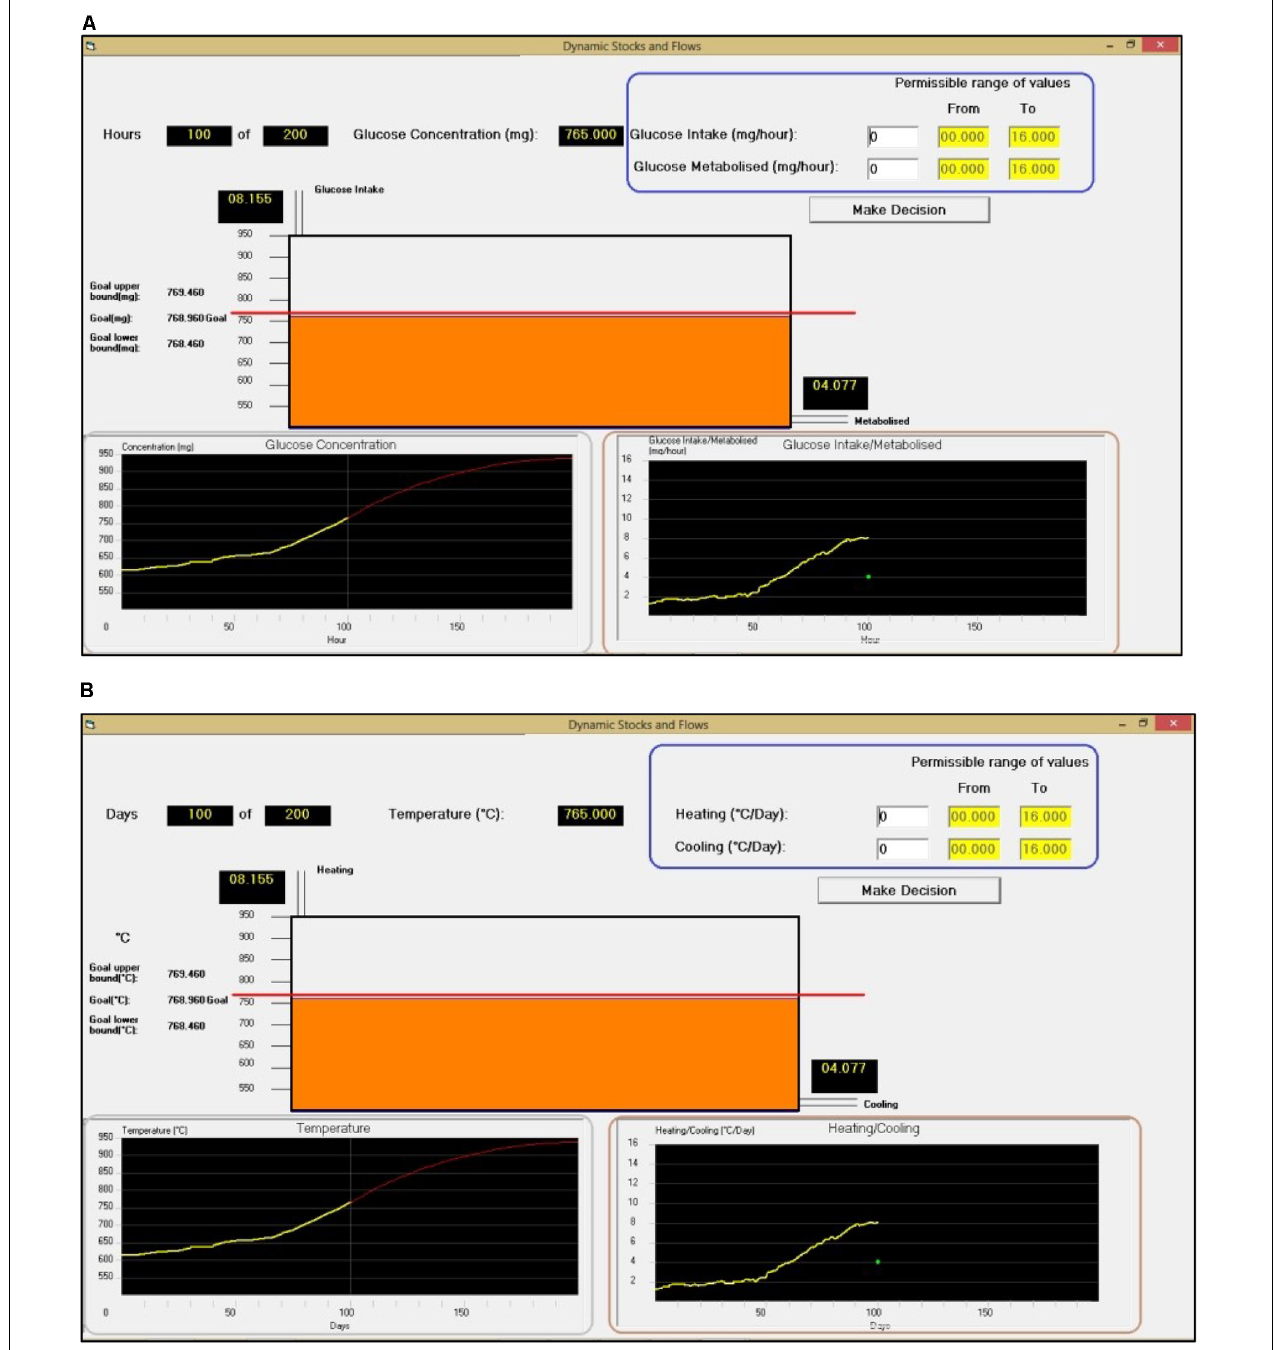
FIGURE 3 | Dynamic Climate Change Simulator tasks in the DCCS-Surface condition where participants need to decide the inflow and outflow values every 5 time periods such that the accumulation (Glucose Concentration or Temperature) followed the red trajectory in the bottom-left Figure. (A) DCCS with the glucose cover story (DCCS-Gluc). (B) DCCS with the temperature cover story